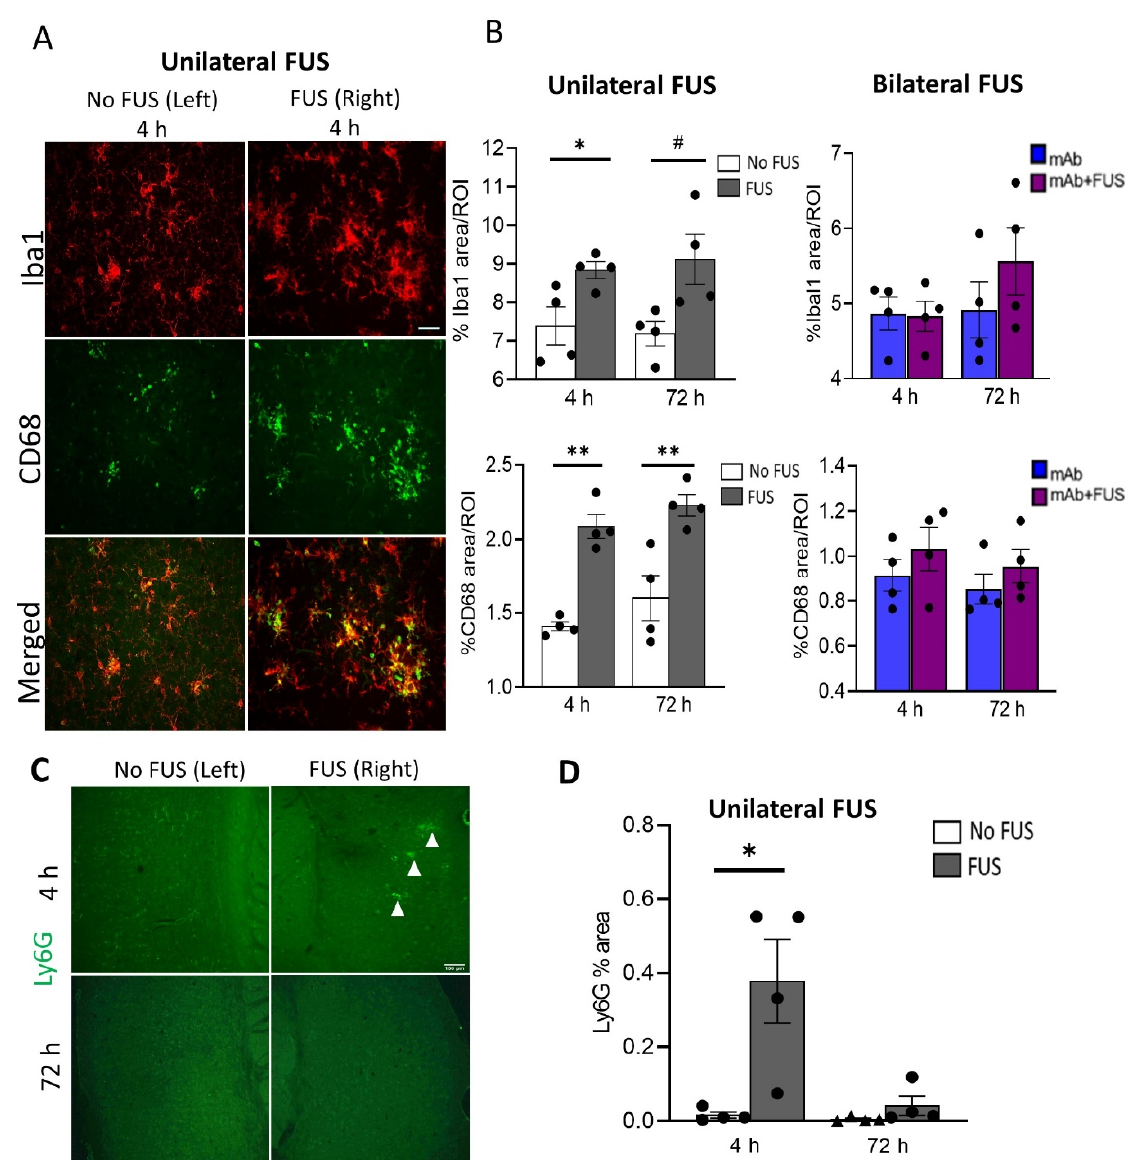
Figure 3. Acute immune response after single dose of 07/2a and FUS treatment. ( A ) Representative images (20×) for Iba1 and CD68 immunoreactivity after 4 h of 07/2a administration and unilateral sonication on the right hemisphere indicating increased microglial area coverage in the cortex com- pared to the non-FUS contralateral left hemisphere. ( B ) Quantitative analysis for general microglial marker (Iba1) and phagocytic marker (CD68) coverage in the cortical region from unilateral FUS cohort. After 07/2a mAb administration and sonication on the right hemisphere an increase in glial activity was seen compared to the contralateral left hemisphere (No FUS) control. Paired t-tests (two-tailed, α = 0.05). In the bilateral FUS cohort, 07/2a mAb treated alone or 07/2a + FUS treated mice after 4 h and 72 h post treatment showed a slight increase in glial activity. Data are represented as mean ± SEM. Two-Way ANOVA with Bonferroni’s multiple comparison test. ( C ) Representative pictures (4×) of Ly6G staining after 4 & 72 h treatment in the sonicated right hemisphere and con- tralateral non sonicated hemisphere. White arrowheads indicate Ly6G + staining. ( D ) Area positive for Ly6G measured in the 4 h & 72 h unilateral FUS cohort expressed as percentage cerebral area, Paired t -tests (two-tailed, α = 0.05). Black dots represent data from individual mice. # p = 0.05, * p < 0.05, ** p < 0.005. Scale bar ( B ) = 50µm, ( D ) = 100 µm.